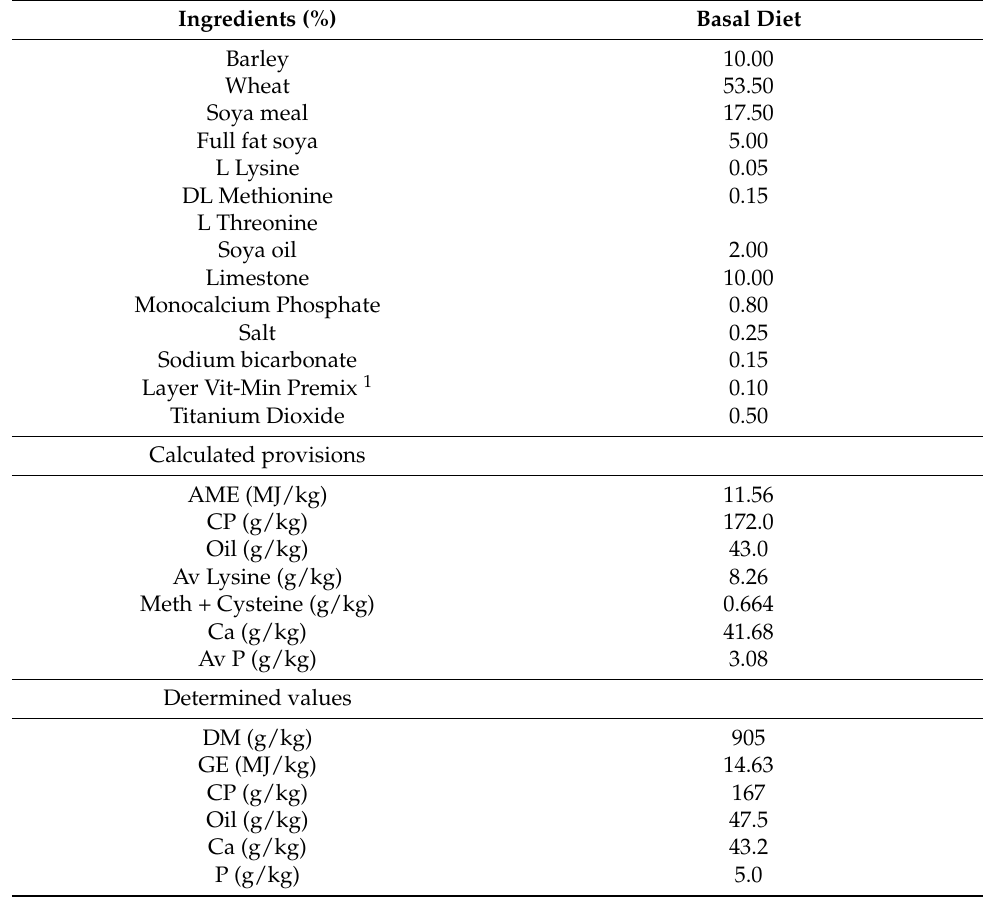
Table 1. Formulation of the experimental basal